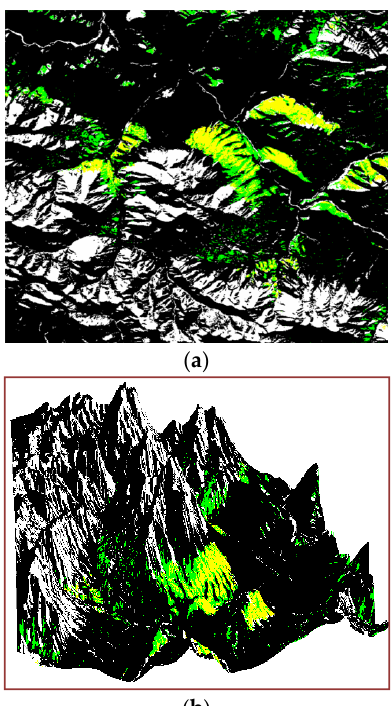
Figure 6. Snow extraction results with NDFSI in forest areas and with NDSI in non-forest areas. ( a ) The snow extraction results; ( b ) the 3D representation of the snow distribution.